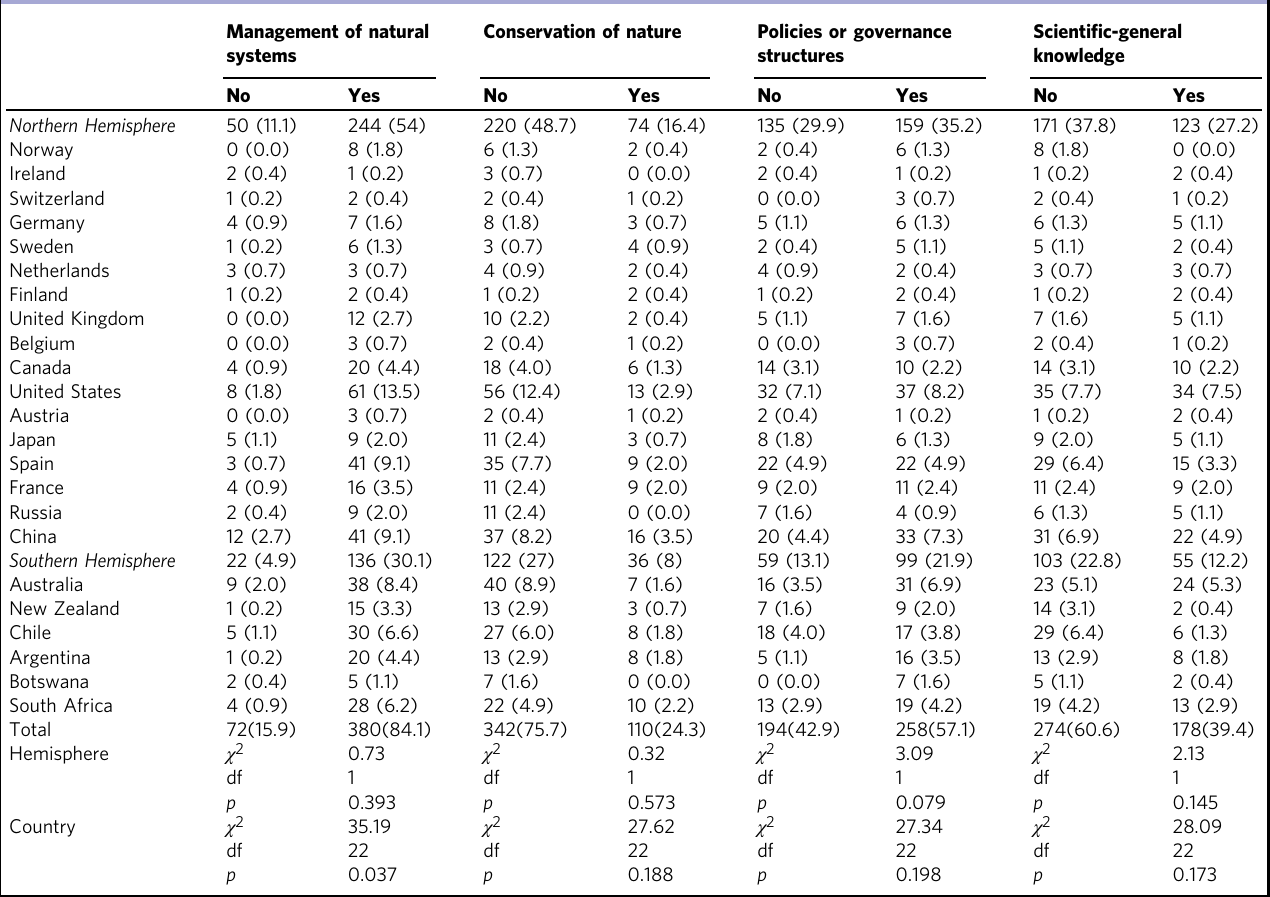
Table 2 Number of observations expressed in absolute frequencies and frequencies relative to the total in percentage (data in parentheses) based on main recommendations derived from socio-ecological studies and their association with the Country and Hemisphere ( χ 2 = chi-square test, df = degree of free, p -value at